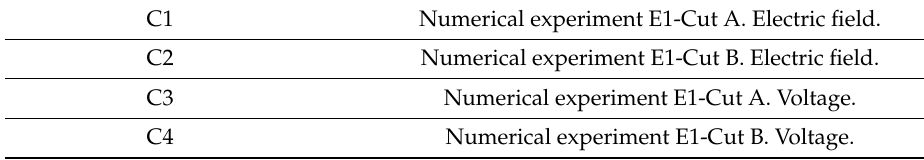
Table 2. Comparisons of developed numerical